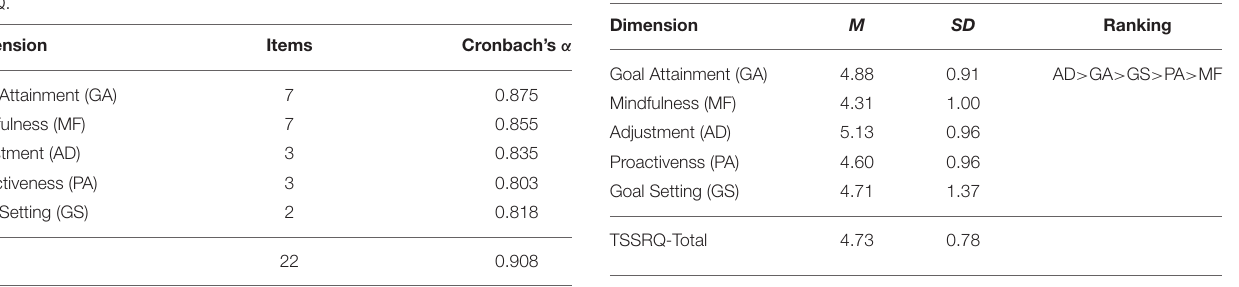
TABLE 6 | Taiwanese college students’ self-regulation profiles.